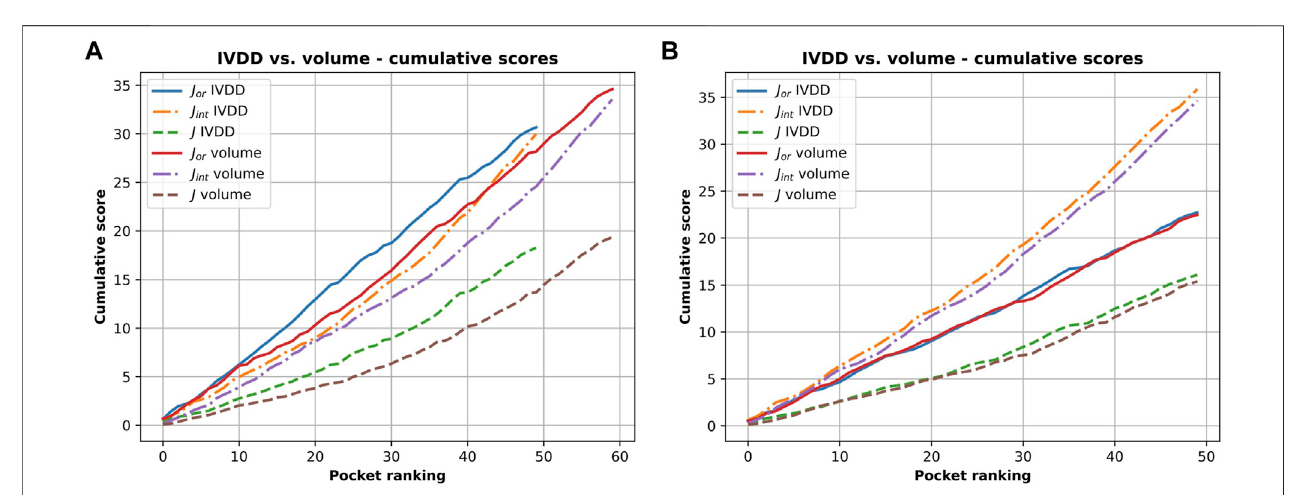
FIGURE 11 | Cumulative scores ( J , J or and J int ) for IVDD and volume ranking. Here, the orthosteric sites identi fi ed by IVDD and the volume ranking in top 1 are considered and ranked according to the probability score and the volume, respectively. Both the rankings are in descending order. Inset (A) is results without hydrogen atoms and inset (B) is with hydrogen